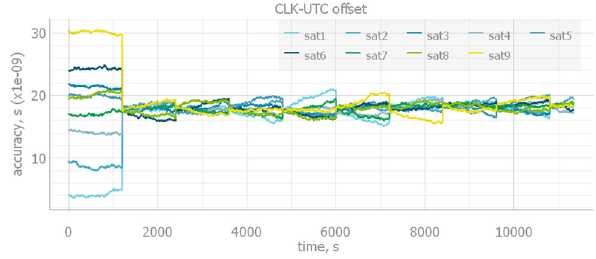
Figure 11: O ff set between satellite clocks and UTC.